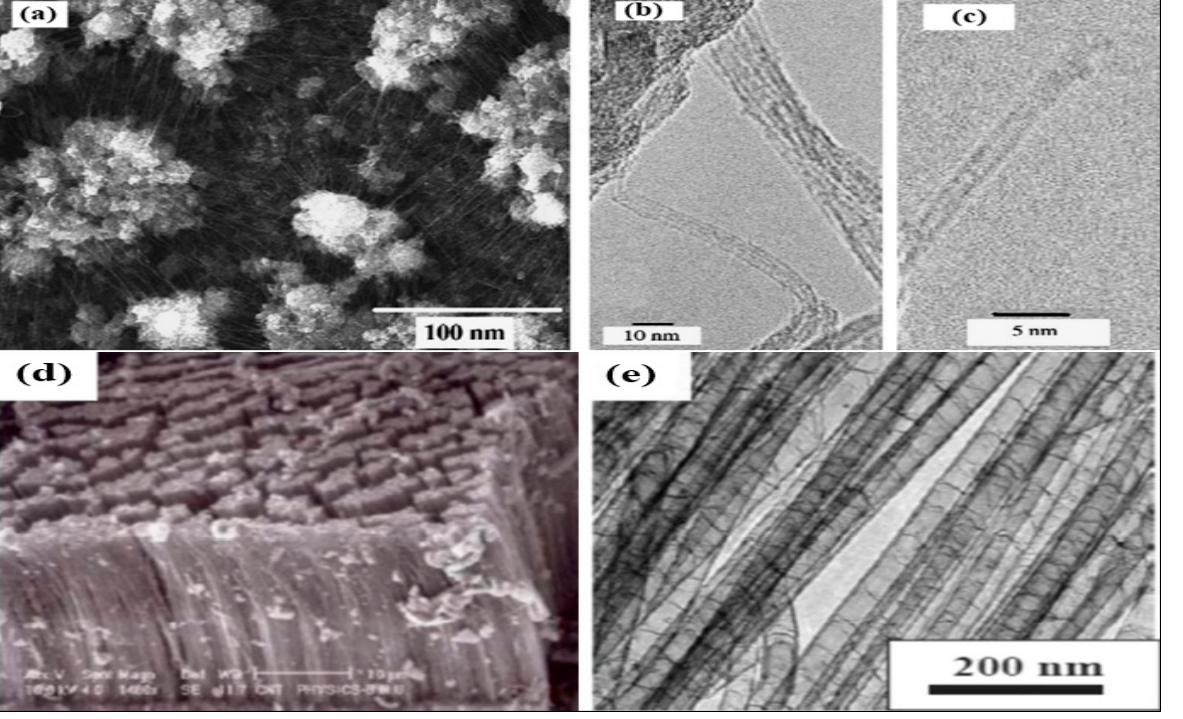
Figure 5. ( a ) SEM, ( b , c ) HRTEM images of SWCNTs grew in the zeolite matrix, Nitrogen doped CNTs using sunflower oil ( d ) SEM image and ( e ) TEM image (Reprinted with permission from [98] Elsevier, License No. 5399121364489).